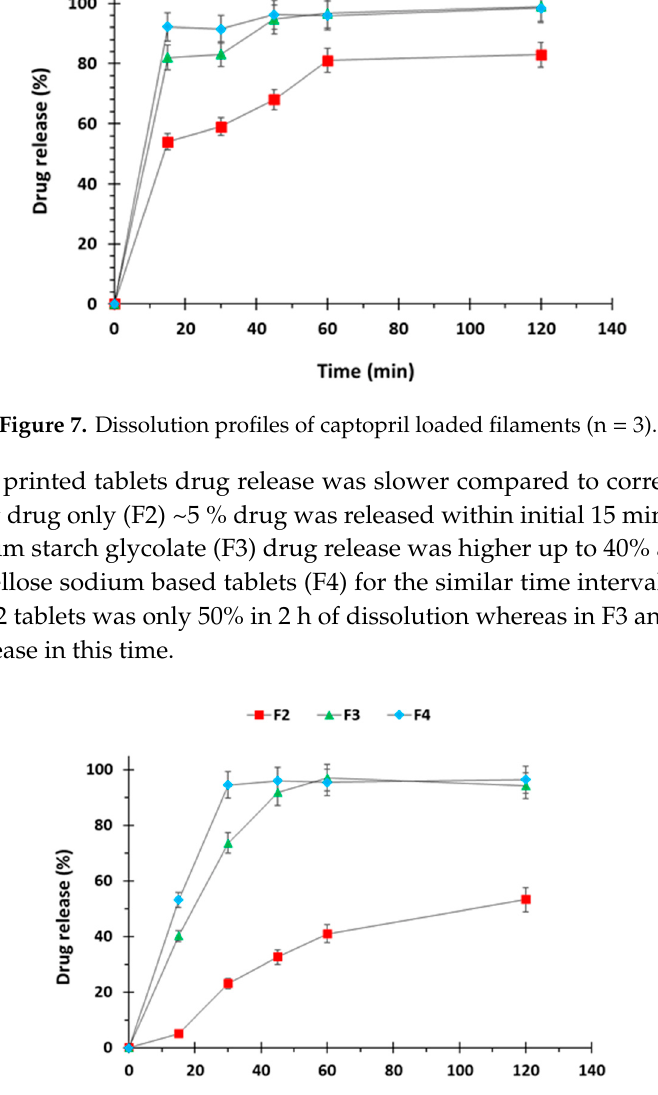
Figure 8. Dissolution profiles of 3D printed captopril tablets (n = 3).